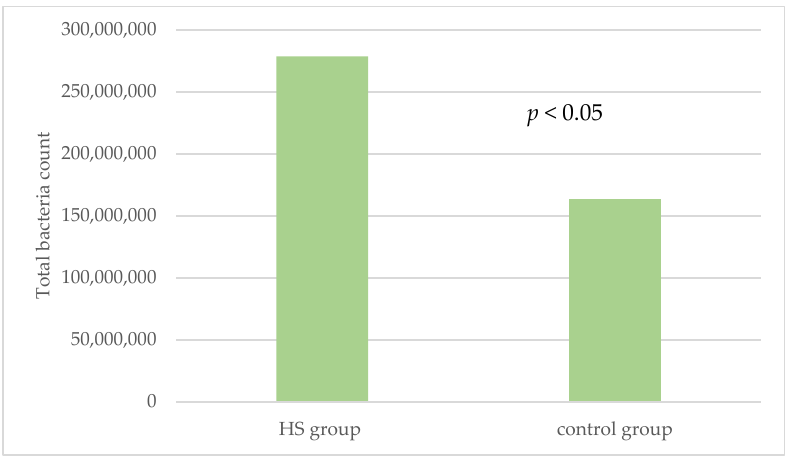
Figure 2. Average copy-counts number of total bacteria in the HS group and the control group. HS: hidradenitis suppurativa. The majority of periopathogens tested were expressed at variable levels in the study